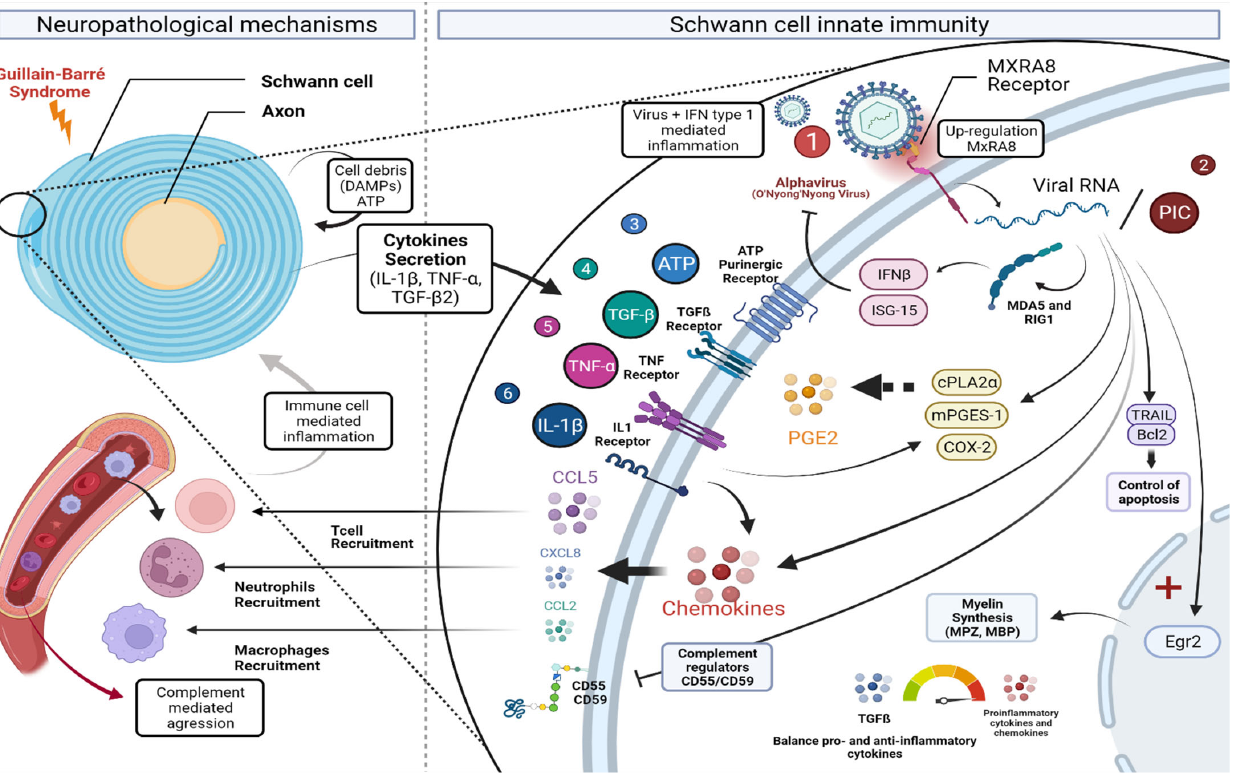
Figure 12. Summary figure: Primary infection of Schwann cells by alphaviruses and highlighting the different potential mechanisms of infective inflammatory neuropathies. Several mechanisms (yet ill ‐ characterized) may be involved to instigate the inflammatory GBS ‐ like response in periph ‐ eral nerves of patients infected by “old world alphaviruses” such as Chikungunya or O’Nyong Nyong Virus (ONNV). Canonically, it is well established that a pathogen can infiltrate a damaged blood peripheral nerve barrier and to cause bystander (indirect) injury to Schwann cells, demye ‐ lination, and axonal injury. Host cell debris (damage ‐ associated molecular patterns DAMPs/alarm ‐ ins such as ATP, HMGB1) may contribute further to the local inflammatory process. Indeed, the recruitment by chemokines (CCL2, CCL5, CXCL8) of innate (neutrophils, monocytes, and differen ‐ tiating into macrophages) and adaptive (T lymphocytes) immune cells to the nerve will lead to the release of cytotoxic proinflammatory cytokines (IL1 ‐β , TNF ‐α ), outweighing those with anti ‐ inflam ‐ matory activities (IL10, TGF ‐β ). Other components such as prostaglandins (PGE2), complement, will stimulate altogether macrophages to phagocytose complement ‐ or antibody ‐ opsonized cell debris, including degraded myelin and axons. Critically, our data highlight herein, for the first time, a pos ‐ sible more direct mechanism of nerve injury after alphavirus infection. First, we describe that, in fact, SC expressing the MxRA8 alphavirus receptor can be infected directly by the prototype ONNV and yet capable of mounting a robust anti ‐ viral response (IFN type I and ISG, e.g., ISG15) and as verified using the PIC viral analogue molecule . ONNV ‐ infected SC were also mobilized in the robust production of all major inflammatory molecules listed above. We further observed that the infection led to upregulated expression of three key enzymes involved in the biosynthesis of PGE2 (cPLA2 α , mPGES ‐ 1, and COX ‐ 2). The pro ‐ inflammatory effects of ONNV infection (as tested at different MOI) were comparable (or even stronger) to that observed when SC were stimulated with recombinant cytokines or ATP to . Interestingly, we also observed that ONNV ‐ infected SC were able to upregulate several key factors associated with immunoregulation and tissue home ‐ ostasis. In response to infection, SC upregulated the expression of molecules involved in the control of apoptosis (e.g., Bcl 2) and, unexpectedly, the expression of myelin (transcription factor Egr2, My ‐ elin P zero (MPZ), and MBP). Collectively, our original data suggest that GBS could potentially be mediated by a direct viral effect on SC. Alphaviruses can replicate within SC and induce a robust immunomodulatory response with potential importance in the GBS ‐ like neuropathology. Figure created with Biorender.com (accessed on 5 May 2022).